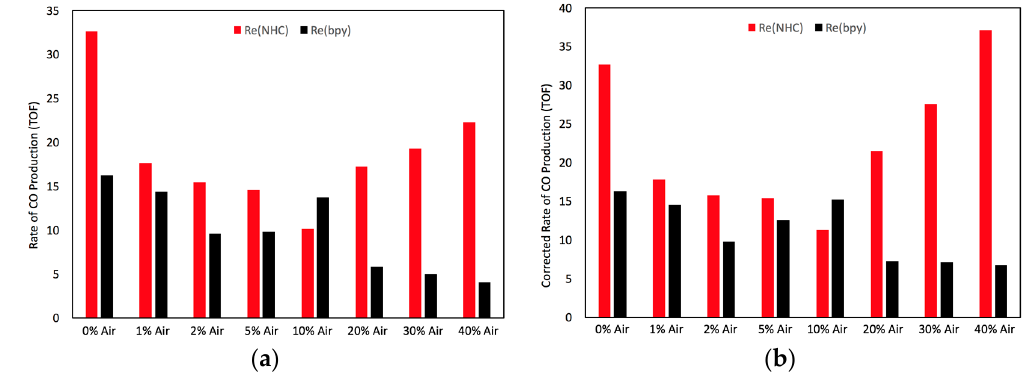
Figure 7. Maximum turnover frequency (TOF) values for Re(pyNHC-PhCF 3 )(CO) 3 Cl and Re(bpy)(CO) 3 Cl with varying percentages of air ( a ) without normalization and ( b ) with normalization to percentage of CO 2 present.